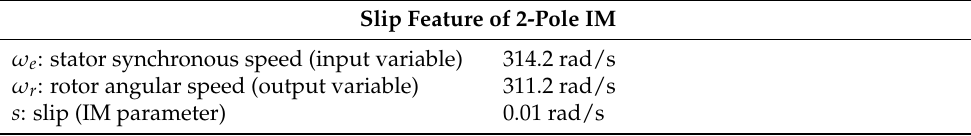
Table 1. Synchronous and rotor